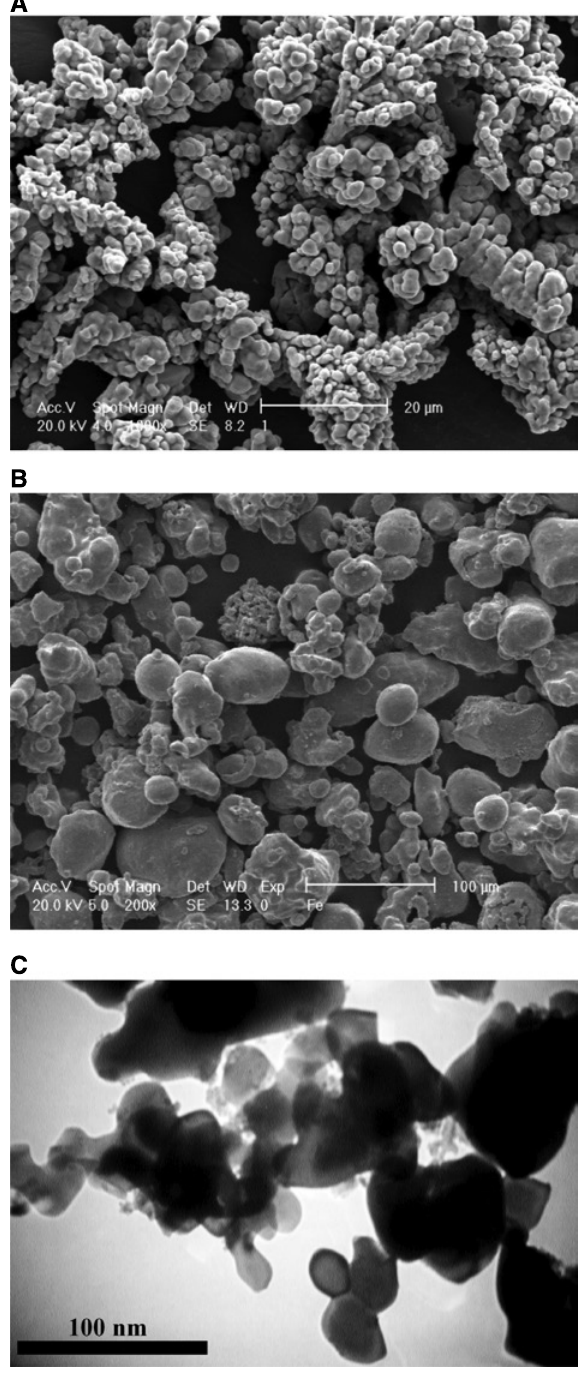
Figure 1: SEM micrograph of powder particles of (A) Cu and (B) Fe and (C) TEM micrograph of alumina nanoparticles prior to mechani- cal